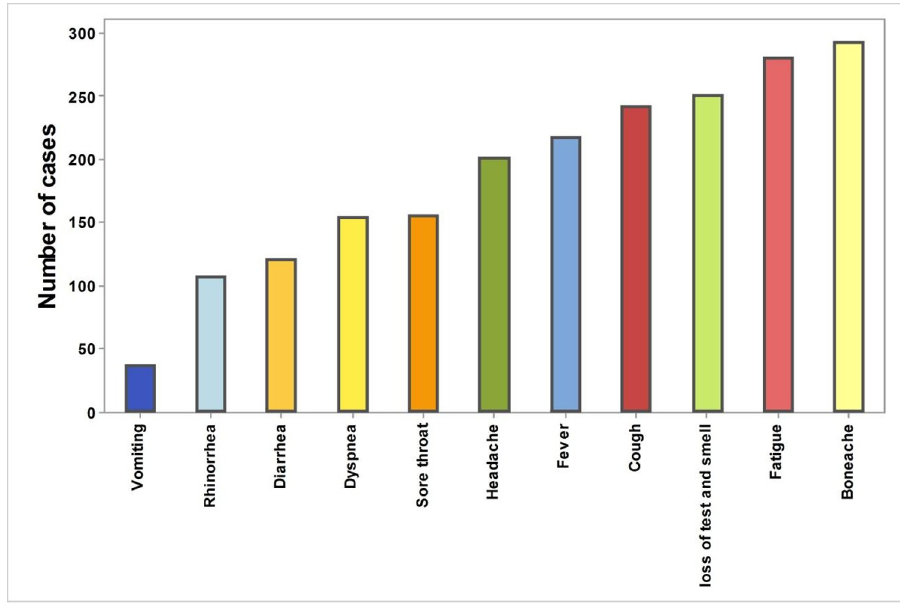
Fig 1. Frequency of different COVID-19 symptoms.